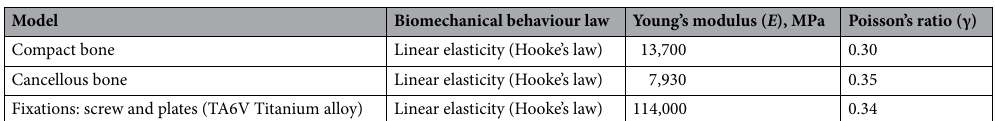
Table 1. Assigned mechanical properties of different